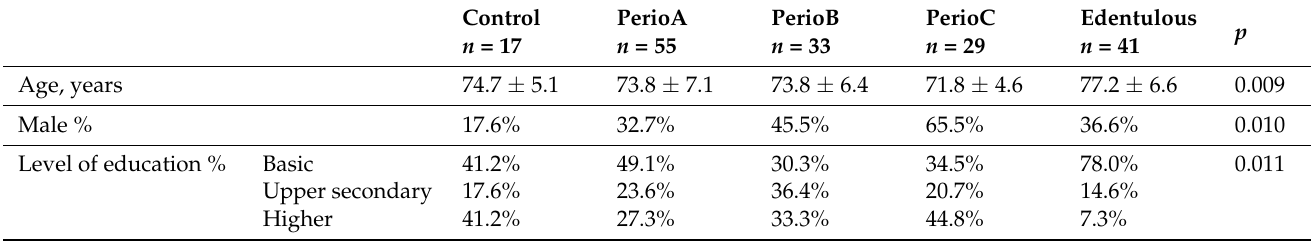
Table 1. The characteristics of the study population. Age and number of teeth are presented as mean ± standard deviation. Males, level of education, and smokers are given as percentages. Body mass indexes (BMI, kg/m 2 ) are presented as medians and interquartile ranges in